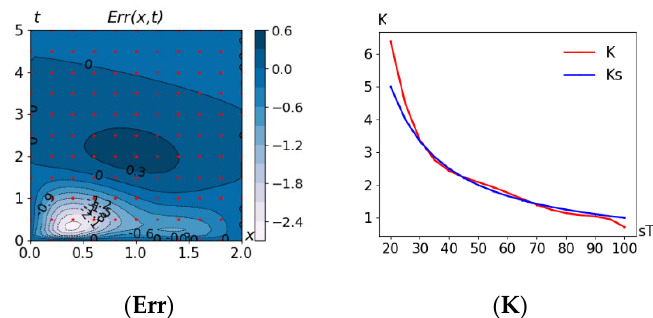
Figure 6. SvF solution of Problem 5.3: ( Err ) Err(x,t) = T(x,t)-Ts(x,t) ; ( K ) the thermal conductivity coefficient K(t) .